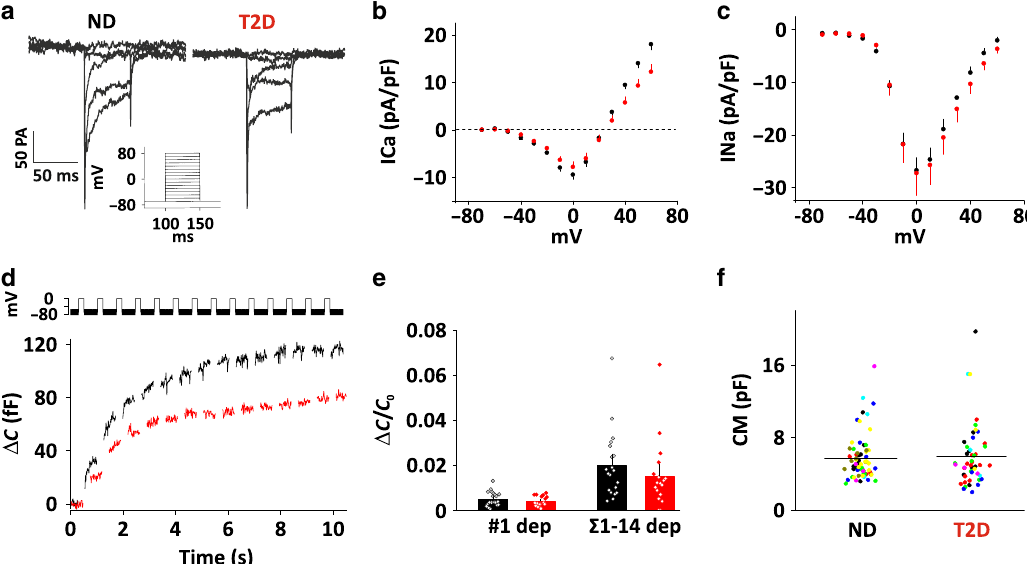
Fig. 2 Voltage-dependent currents and exocytosis in human α -cells. a Families of voltage-clamp current responses in human ND and T2D α -cells. Currents were elicited by 50 ms depolarizing pulses ( − 70 to + 80 mV in 10 mV increments) from a holding potential of − 70 mV. For clarity, only the responses between − 40 mV and + 10 are shown. b , c Current (I) – voltage (V) relationships for Ca 2 + (B, average current during 5 – 45 ms of the depolarization in a ) and Na + ( c , peak current during the fi rst 5 ms of the depolarization in a ) currents recorded from ND ( n = 38, 4 donors, black) and diabetic T2D ( n = 32, 3 donors, red) cells as in a . Currents are normalized to cell size (pF). Data are presented as mean values ± SEM. d Cell capacitance increase ( Δ Cm) during a train of 14 × 200-ms depolarizations from − 70 mV to 0 mV in ND (black) and T2D (red) α -cells. e Average change in membrane capacitance, normalized to initial cell capacitance ( Δ C / C 0 ), during the 1st depolarization (#1), and total increase during the train ( Σ 1-14) for ND ( n = 20, 4 donors, black) and T2D ( n = 18, 3 donors, red) α -cells. Data are presented as mean values ± SEM. f Whole-cell membrane capacitance (CM) in T2D ( n = 48, 7 donors) and ND ( n = 66, black, 8 donors) α -cells. Dots represent individual cells, and lines are mean values. Each donor is represented by a single